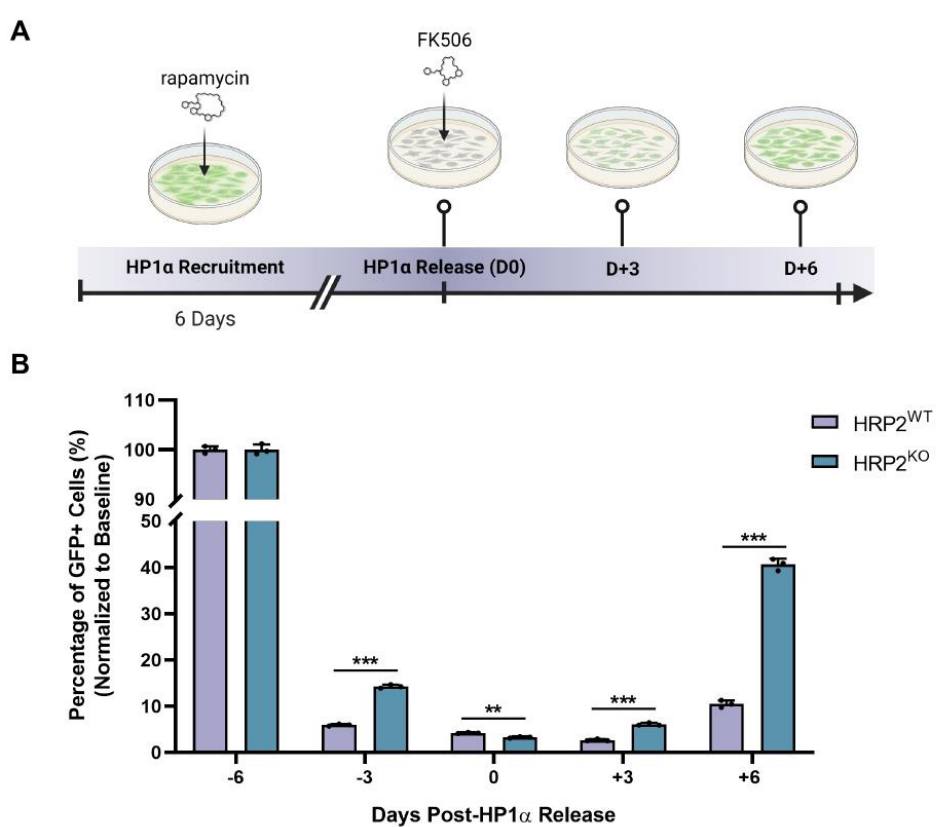
Figure 4. Loss of HRP2 disrupts HP1 α -mediated heterochromatin stability. ( A ) Schematic of time